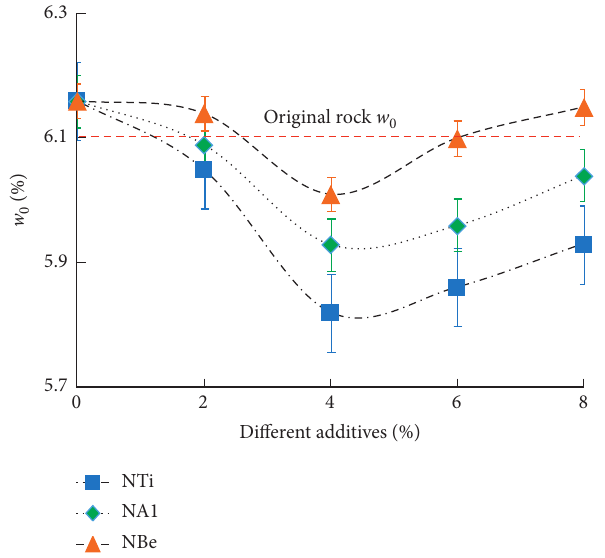
Figure 4: Effects of nanoadditives on natural water absorption parameters of similar materials.